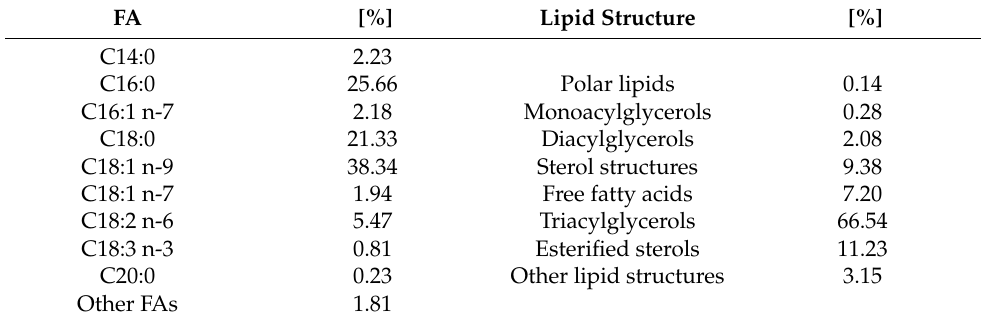
Table 1. Fatty acid (FA) composition and percentage of individual lipid components of animal fat material used for the solid-state fermentation by Umbelopsis isabellina CCF2412. FA